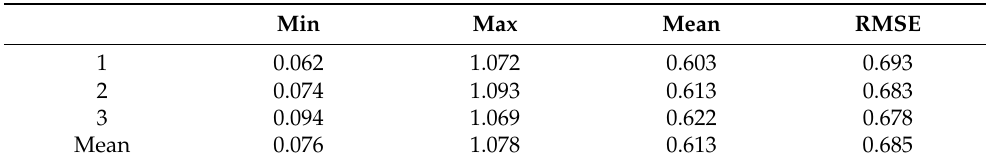
Table 5. Positioning error after coordinate constraint corrections (m). Min Max